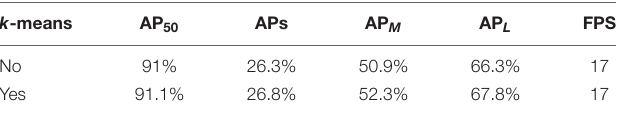
TABLE 5 | Comparison of test results for adjusting the number of anchor boxes and the aspect